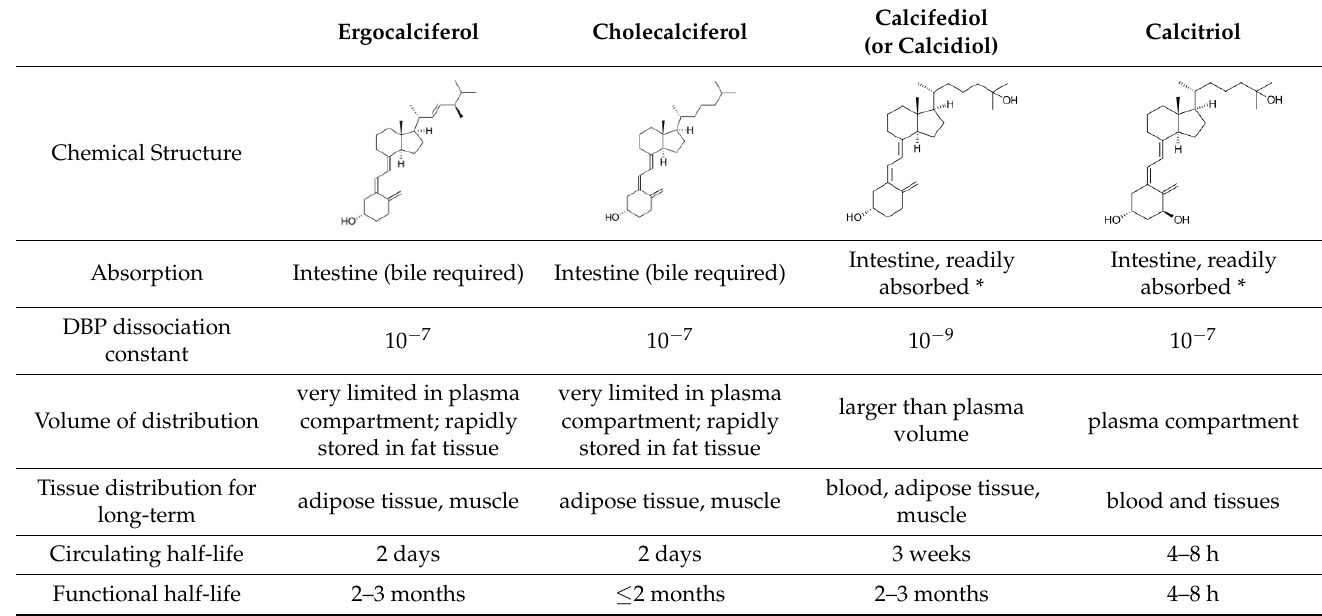
Table 6. Chemical structure and pharmacokinetic characteristics of vitamin D compounds and activated forms. Ergocalciferol